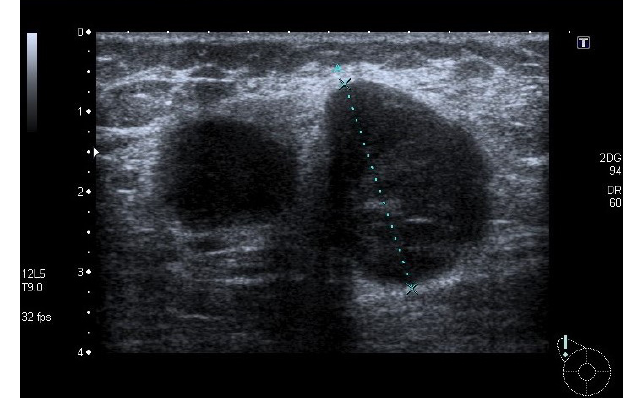
Figure 1. Ultrasonography of nodular formation at the upper external quadrant of the right breast.